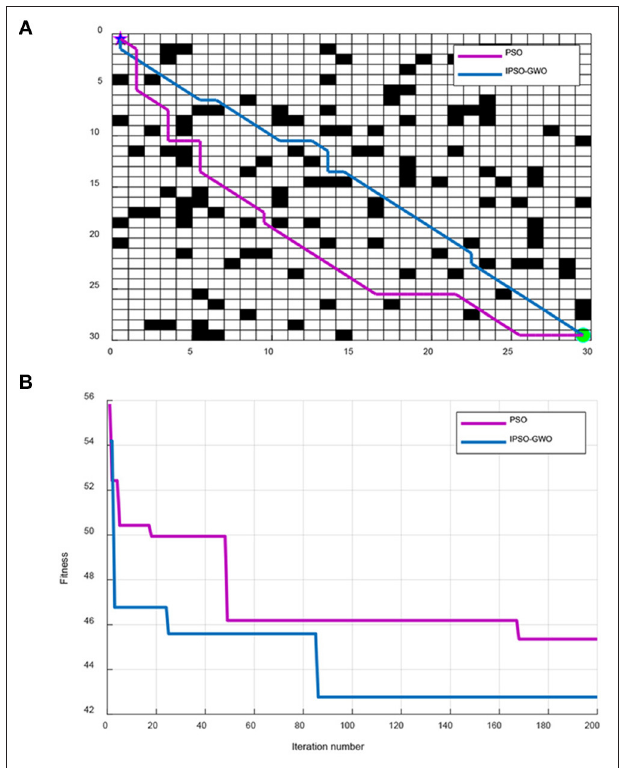
FIGURE 5 | Simulation results of IPSO-GWO and PSO in 30 × 30 map environment. (A) Path comparison with PSO and IPSO-GWO algorithms. (B) Iterative curves with PSO and IPSO-GWO